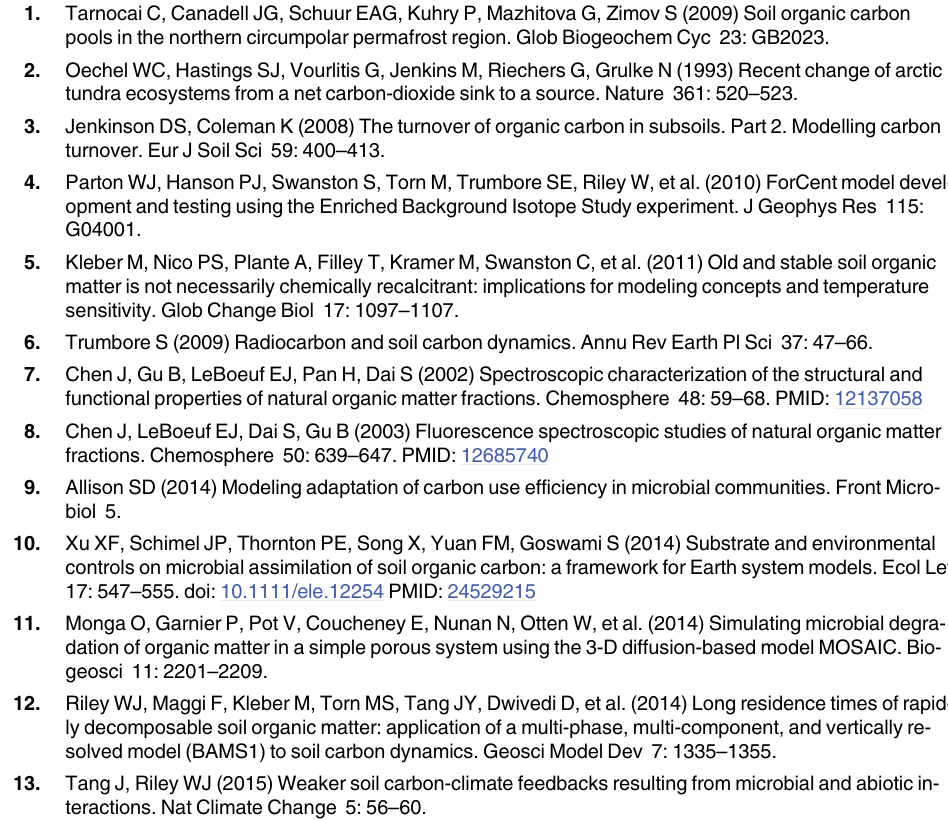
S2 Fig. Cumulative gas production (carbon dioxide (CO simulated 40-day warming incubation experiment with an Arctic mineral soil obtained from Barrow, Alaska, USA. S3 Fig. Plots of O:C vs. mass and H:C vs. mass for BSF0 (a,b) and BSF40 (c,d) SOM